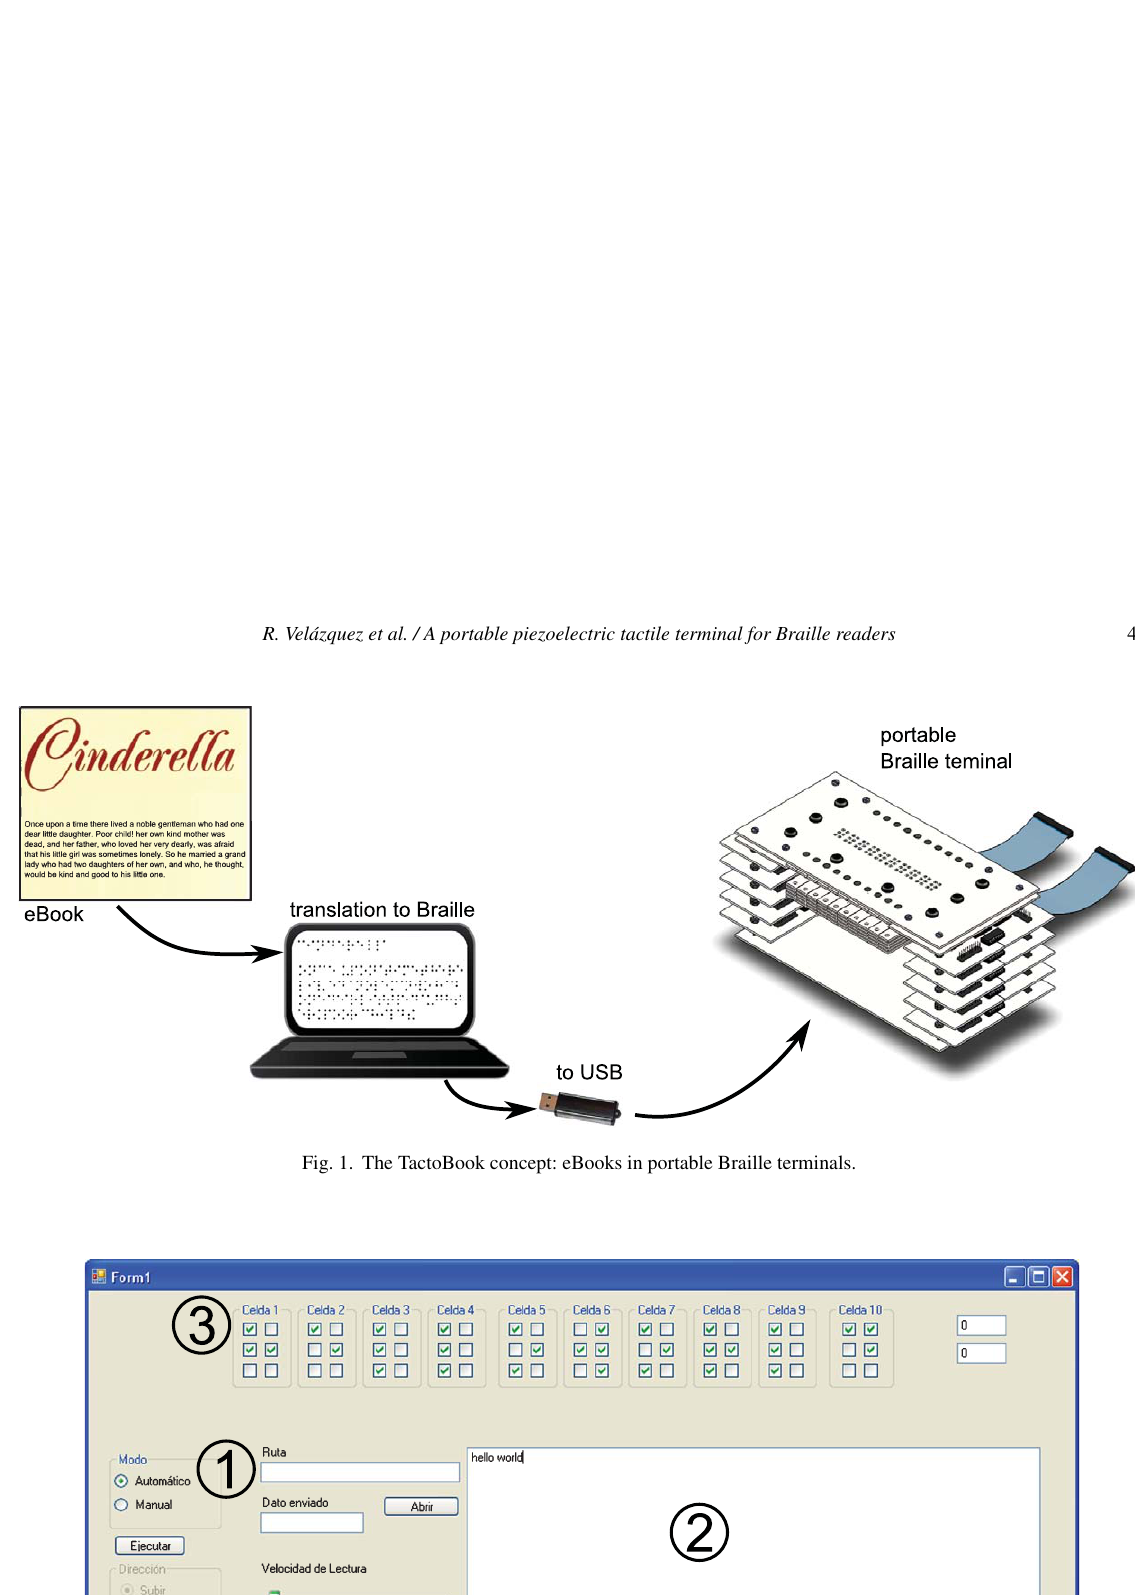
Figure 2 shows a snapshot of the user